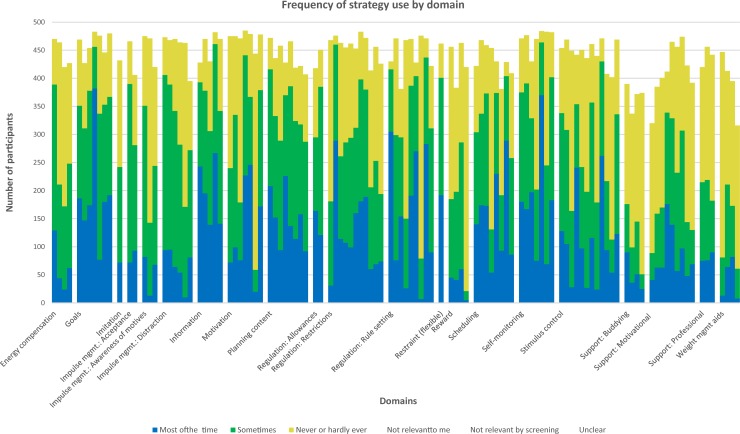
Frequency of strategy use by domain.